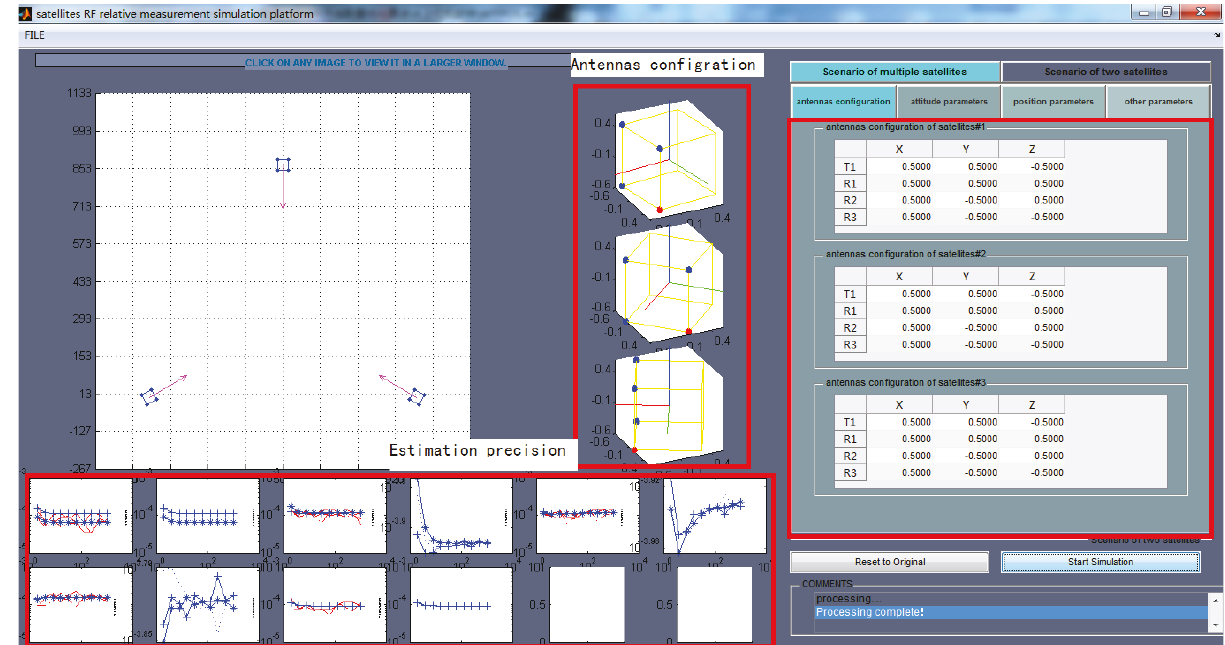
Figure 7: The RF relative measurement sensor con fi guration and analysis system.